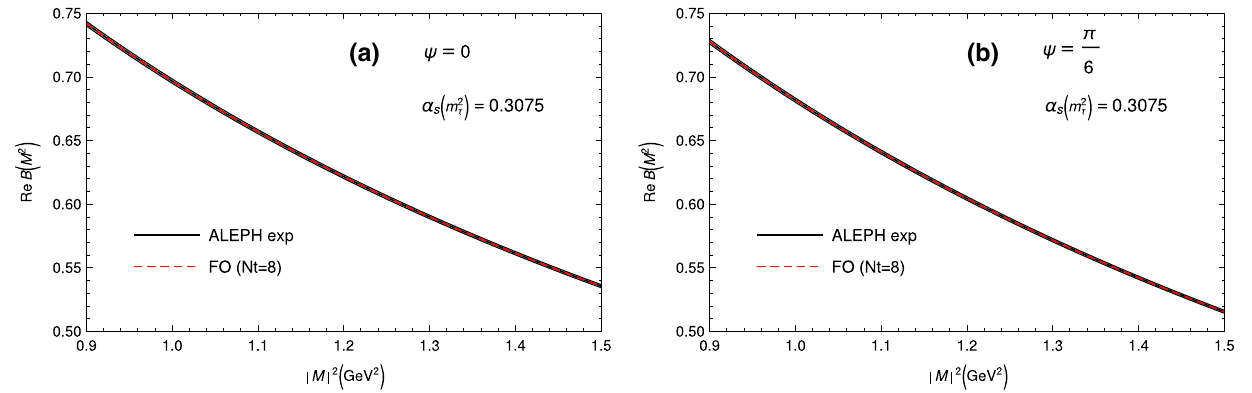
Fig. 5 a and b The values of Re B ( M 2 ; σ m ) along the rays M 2 = | M 2 | exp ( i (cid:17)) with (cid:17) = 0, π/ 6, respectively. The narrow grey band are the experimental predictions. The red dashed line is the result of